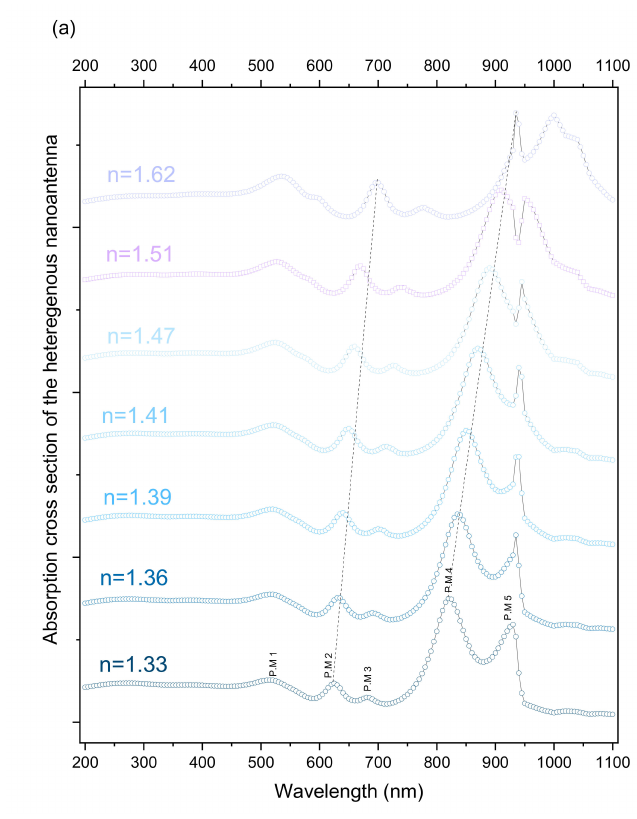
Figure 4. ( a ) Distribution of the field enhancement E loc \ E 0 on the surface of the 3D simulated model of the (i) Si nanoantenna with Ag/Au core shell, (ii) SiO 2 nanoantenna with Ag/Au core shell for 330 nm and 670 nm laser excitation. ( b ) Enhancement factor at variable wavelength for (i) Si, (ii) SiO 2 nanoantenna.